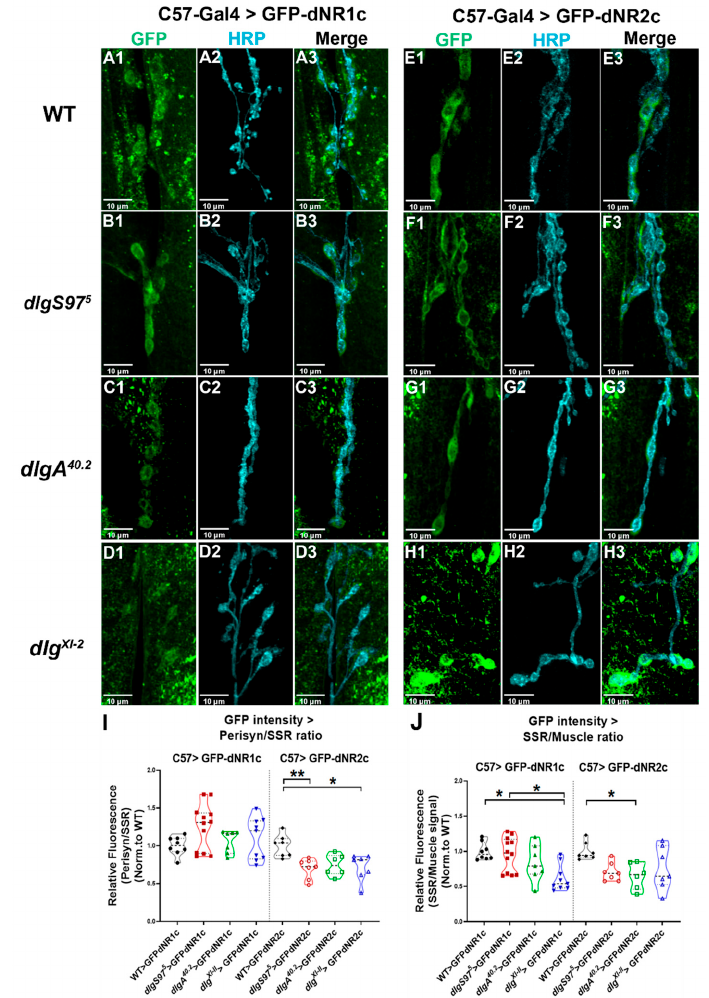
Figure 4. dNR1and dNR2 tails depend on Dlg to reach the synapse. ( A1 – H3 ) Representative images of the distribution of dNR1 (dNR1c) and dNR2 (dNR2c) tails overexpressed in the muscle in control ( A , E ) or dlg mutant flies ( B – D , F – H ) detected by immunofluorescence against GFP ( A , H ) to label the constructs CD8-GFP-dNR1 ( A – D ) or CD8-GFP-dNR2c ( E , H ) to observe its distribution in the mus- cle. Antibodies against HRP were used to label the presynaptic boutons ( A2 – H2 ), merge images are shown ( A3 – H3 ); ( I ) Quantification of the fluorescence intensity in the synapse normalized by the fluorescence in the cytosol for all the genotypes. GFP intensity Peri-synaptic/Sub-synaptic reticulum (SSR) ratio (GFP signal tightly close to HRP labeling area compared to the postsynaptic enlarged area around HRP mark). C57-Gal4>GFP-dNR2c = Kruskal–Wallis, Dunn: ** p < 0.01; N = 7 boutons— 2 larvae; p * < 0.05 N = 7 boutons-2 larvae ( J ) GFP intensity SSR/Muscle ratio (GFP signal restricted to the postsynaptic enlarged area around HRP mark versus Muscle ROIs area). C57-Gal4>GFP- dNR1c = Kruskal–Wallis, Dunn: * p < 0.05; N = 8/12 boutons—2/3 larvae. C57-Gal4>GFP–dNR2c = Kruskal–Wallis, Dunn: * p < 0.05; N = 7 boutons—2 larvae.